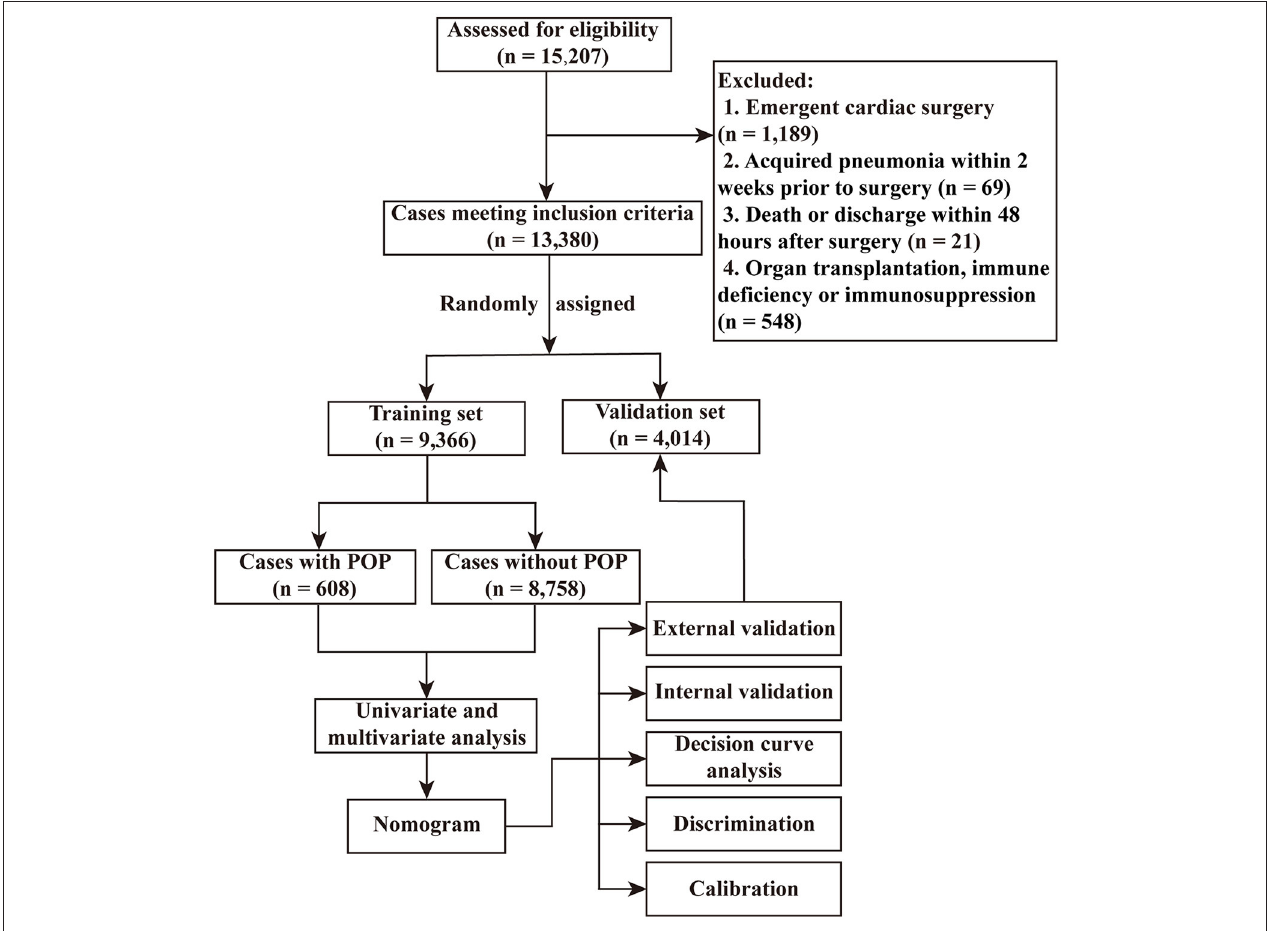
FIGURE 1 | Flow chart of the study. POP, postoperative